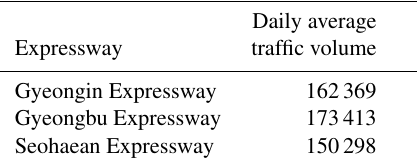
Table 4. Daily average traffic volume on the Gyeongin, Gyeongbu, and Seohaean expressways obtained using the Traffic Monitoring System (https://www.road.re.kr, last access: 28 February